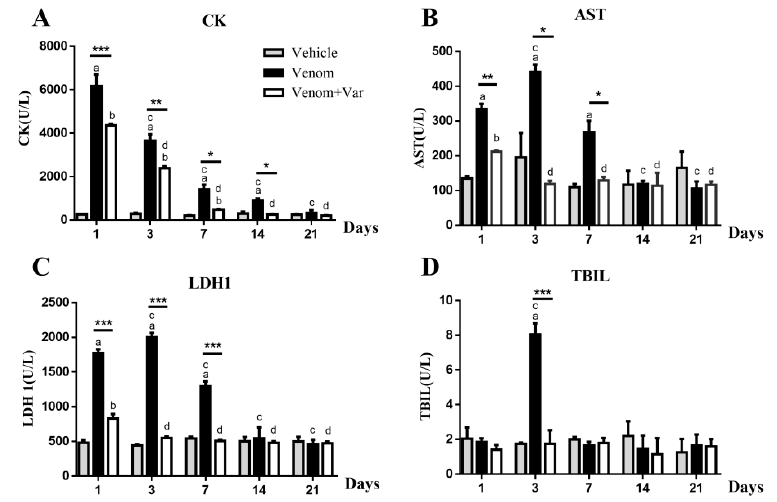
Figure 2. Variation in serum CK, AST, LDH1, and TBIL during a time course rehabilitation of envenomed mice. ( A ) Creatine kinase increased significantly at day 1, indicating an immediate muscle necrosis. Varespladib significantly prevented muscle degeneration; ( B , C ) were serum AST and LDH1 levels, significant increase occurred at the initial 7 days; ( D ) Total bilirubin, a biomarker of erythrocyte degradation, increased substantially at the 3rd day, the time of hemorrhage removal and absorption. Results were presented as means ± SD ( n = 3). * p Venom vs. Venom + Var ( p < 0.05), ** p < 0.01, *** p < 0.001,“a” p < 0.05 Venom vs. Vehicle, “b” p < 0.05 Venom + Var vs. Vehicle, “c” p < 0.05 Venom vs.